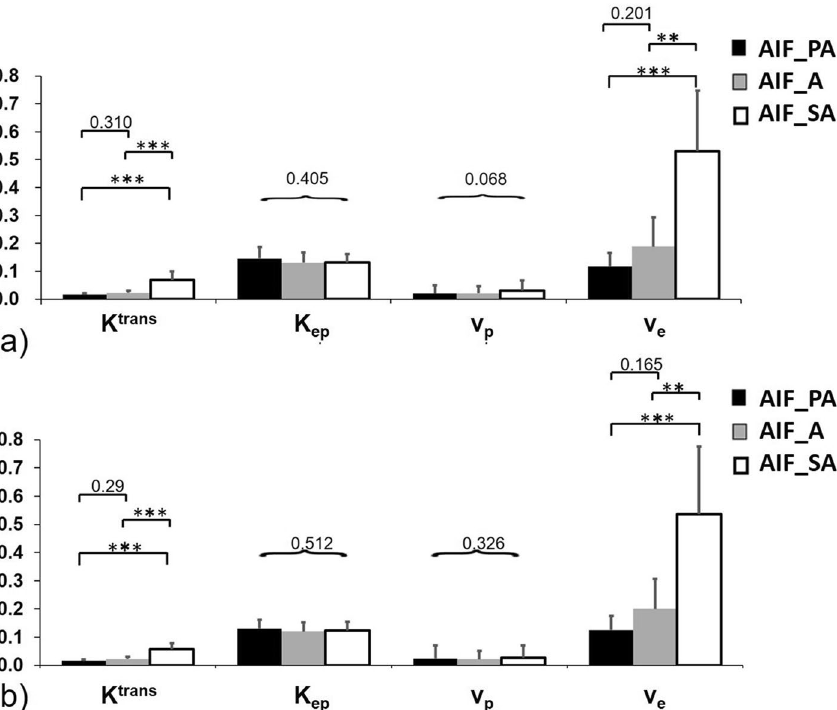
Figure 8. Comparing the perfusion parameters K trans , K ep , v e , and v p between the population-based (Parker) arterial input function (AIF; black), aortic AIF (gray) and segmental arterial AIF (white) using ( a ) a pixel-by- pixel computational method and ( b ) a region-of-interest computational method. Note: data are presented as means and standard derivations. ** P < 0.01, *** P < 0.001.